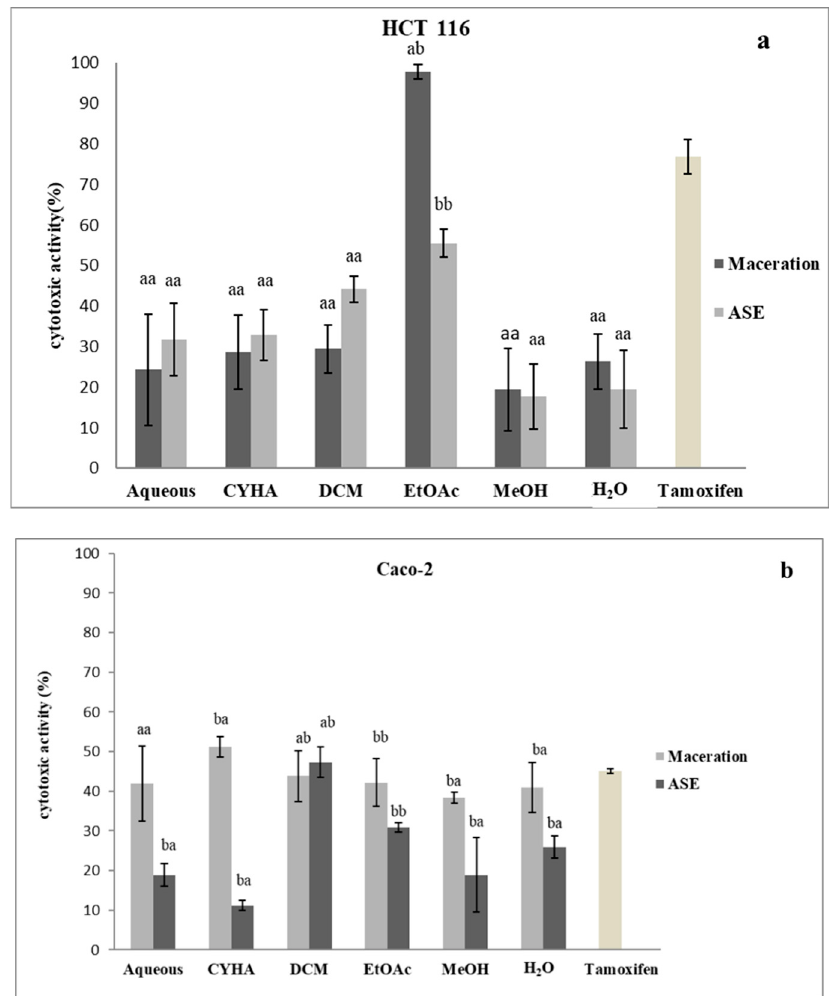
Figure 8. Cytotoxic activity of different extracts of V. vinifera stem against two cell types (HCT 116: ( a ); CaCo-2: ( b )). (CYHA: Cyclohexane; DCM: Dichloromethane; ETOAC: Ethyl acetate; MeOH: Methanol; Tamoxifen: used as referance at 100µM). Extracts were tested at 50 µg/mL. Means values ± SD ( n = 3); Different letter on the histograms means a significant difference ( p ≤ 0.05).